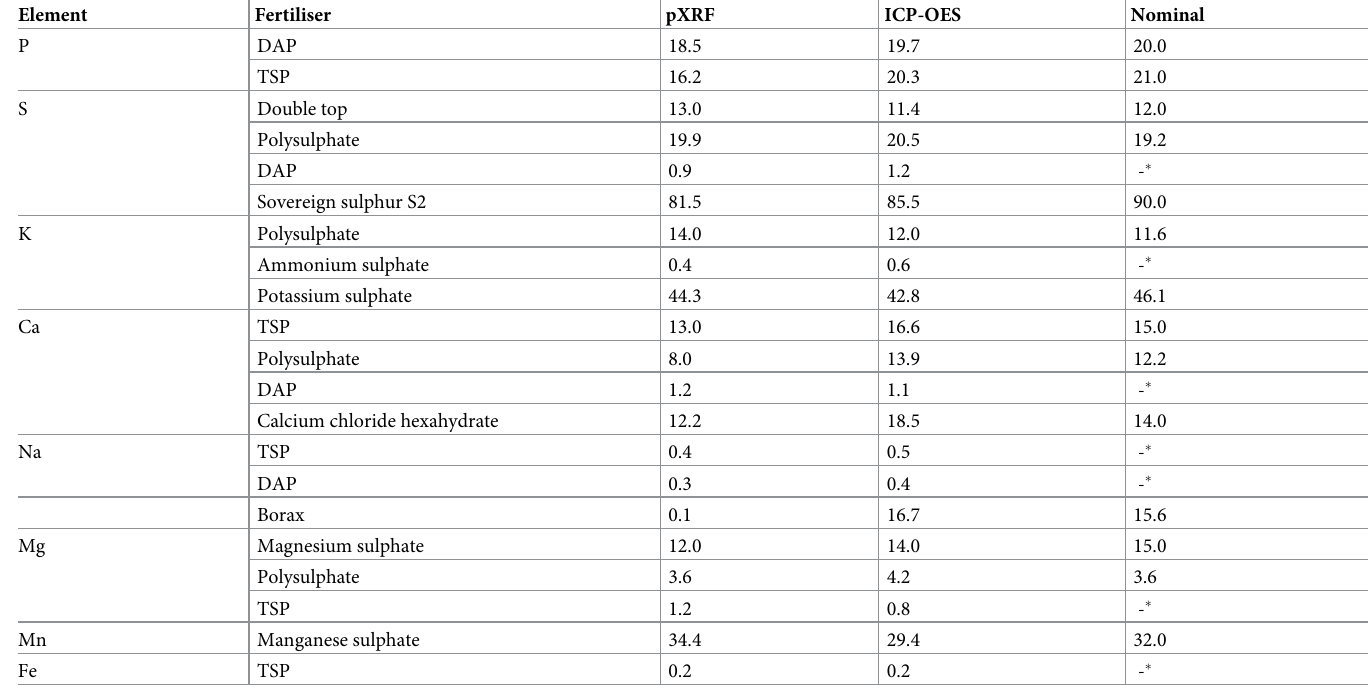
Table 7. Elemental composition (%) of fertilisers as determined by pXRF, ICP and as reported for marketing purposes. Element